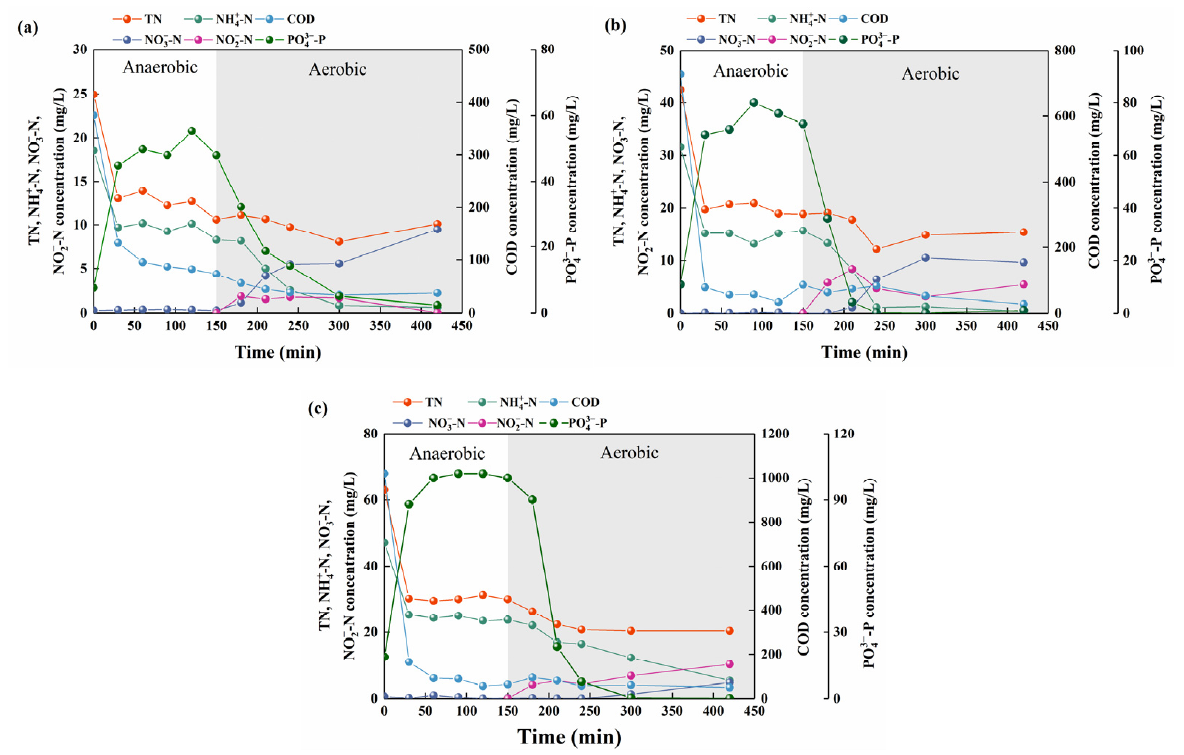
Figure 2. Profiles of COD, TN, NH 4+ -N, NO 3 − -N, NO 2 − -N, and PO 43 − -P concentrations in a typical cycle of SBR: ( a ) Phase I, ( b ) Phase II, and ( c ) Phase III.